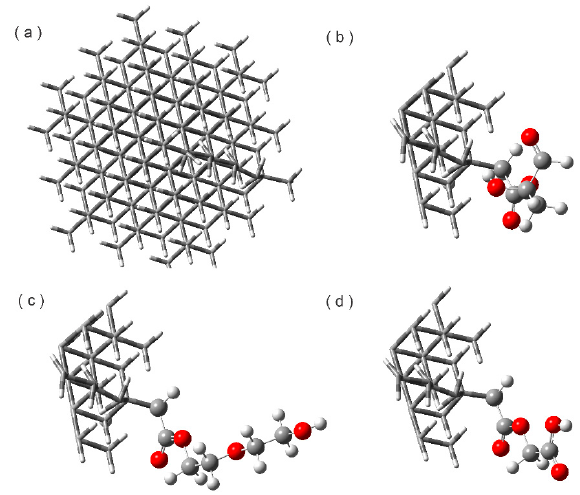
Figure 1. Optimized structures: ( a ) Nanodiamond; ( b ) ND2HP; ( c ) NDPEG; and ( d ) NDPGA at the M06/6–31G(d) level of theory.